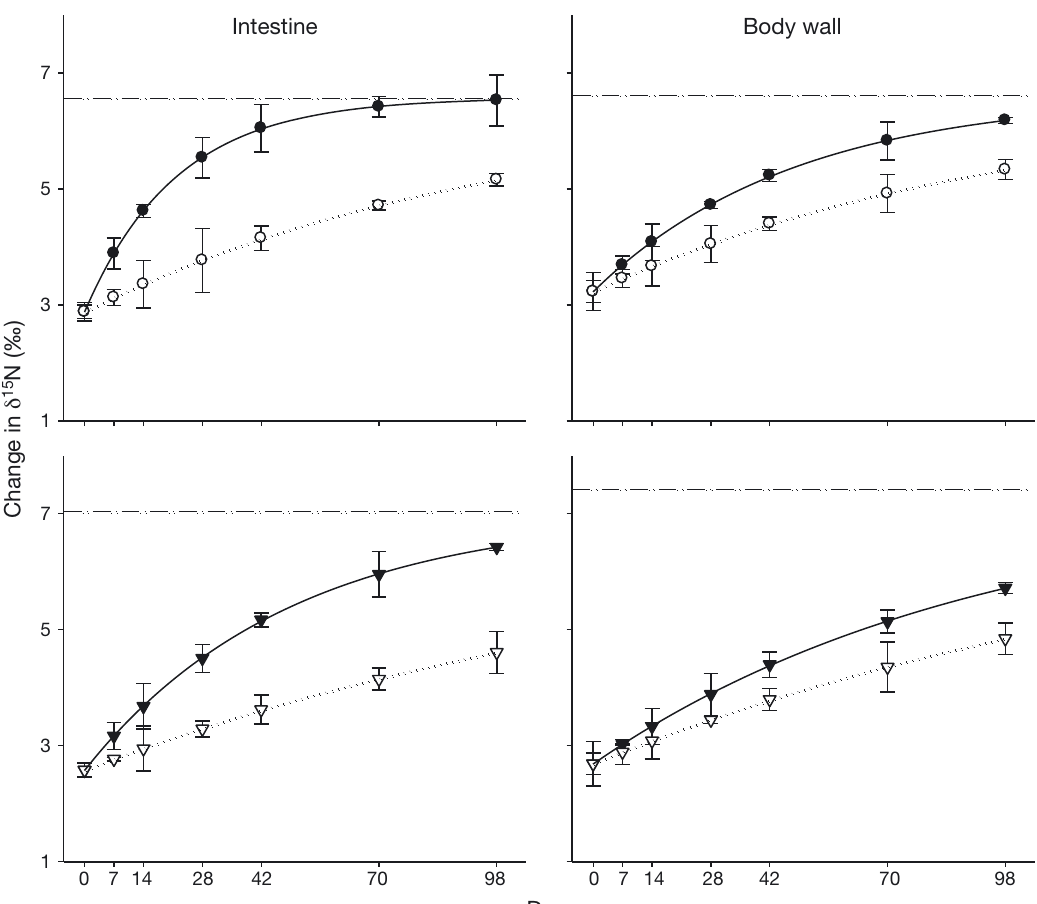
Fig. 4. Changes in the δ 15 N values estimated with time-based turnover model for intestine (left column) and body wall (right column) of green (circles) and white sea cucumber (triangles) fed a premixed artificial diet. Solid lines/filled symbols: δ 15 N val- ues with the contribution of growth and metabolism; dotted lines/open symbols: δ 15 N values with the contribution of growth alone (metabolic turnover constant, m = 0). Horizontal dash-dotted line: expected δ 15 N values when tissues are completely